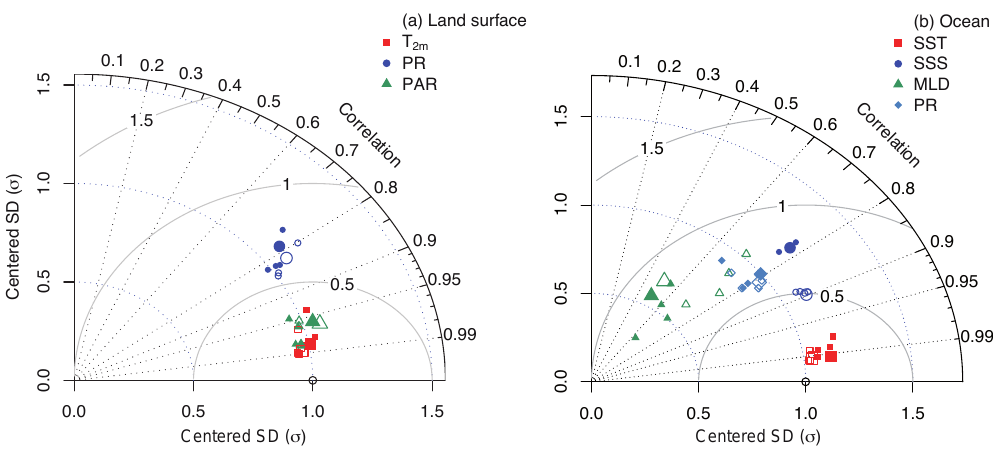
Figure 9. Taylor diagrams showing the correspondence between model results and observations for CNRM-ESM1 and CNRM-CM5.2. Near-surface temperature ( T 2m ) , precipitation (PR) and photosynthetically available radiation (PAR) are used to assess model performance over land surface. Sea surface temperature (SST), sea surface salinity (SSS), mixed-layer depth (MLD) and precipitation (PR) are used to assess model performance over ocean. Filled and empty symbols indicate skills for CNRM-ESM1 and CNRM-CM5.2, respectively. The size of the symbols indicates whether statistics were computed from annual mean climatology or seasonal average (JFM, AMJ, JAS, OND) over